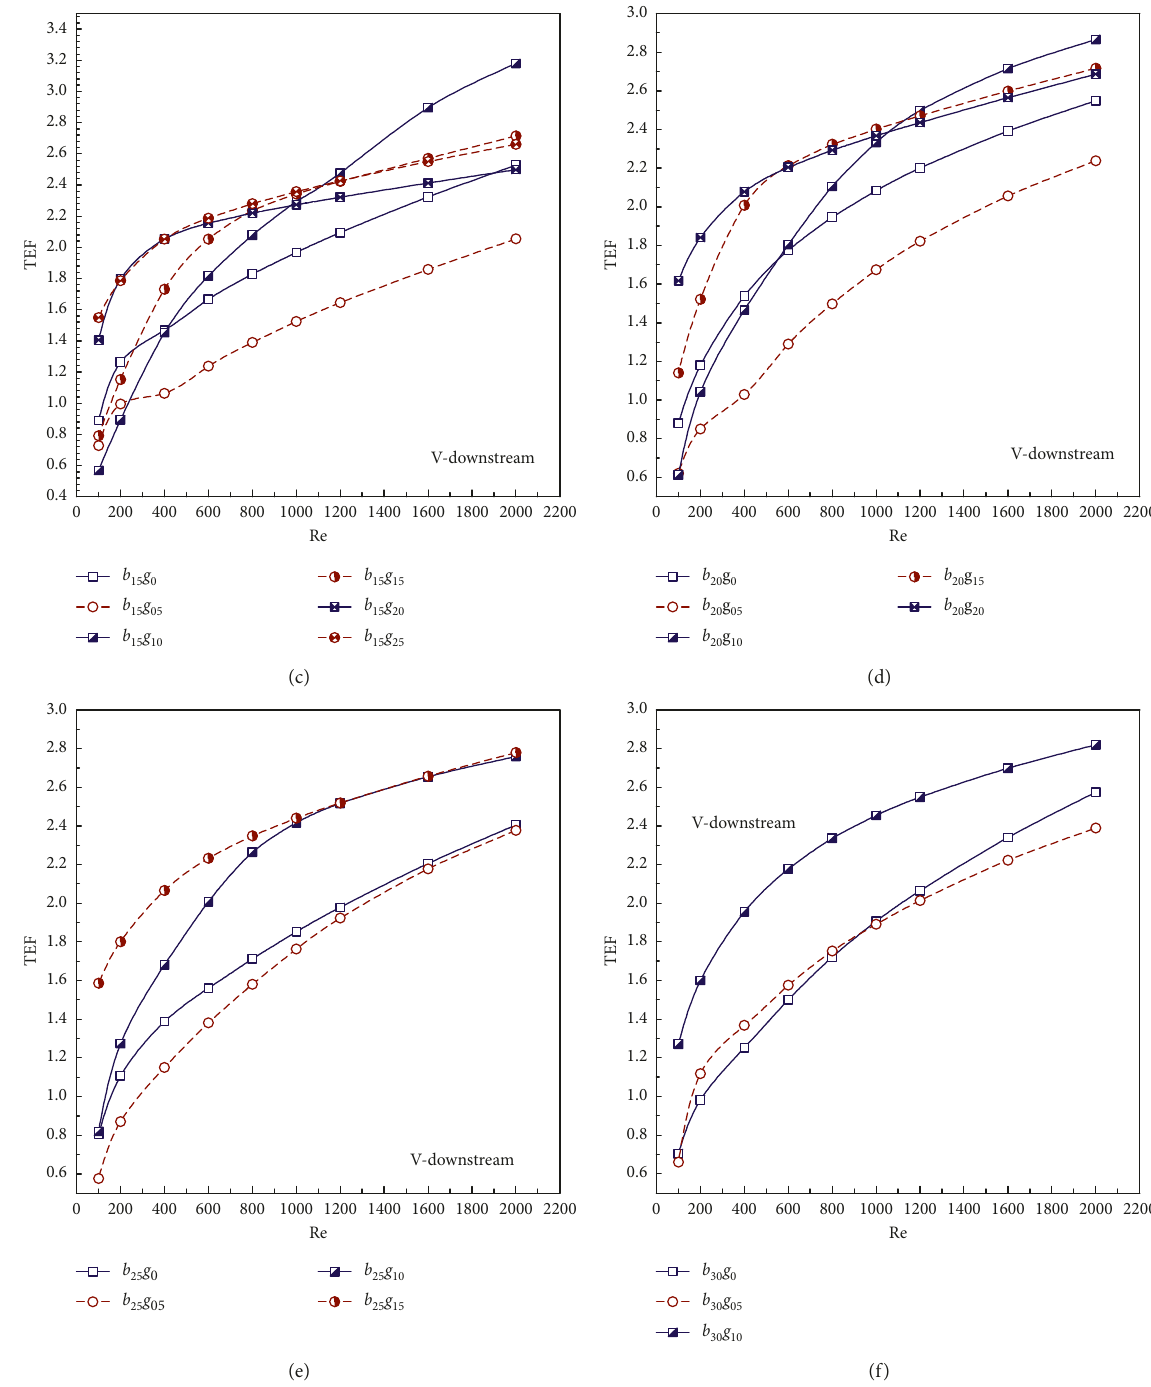
Figure 15: Relation of the TEF with the Reynolds number for (a) b05, (b) b10, (c) b15, (d) b20, (e) b25, and (f) b30 at V-downstream